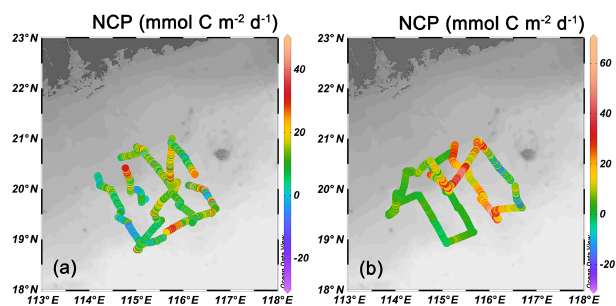
Figure 4. Surface distribution of NCP along the northern slope of the SCS during the cruise in (a) October 2014 and (b) June 2015.